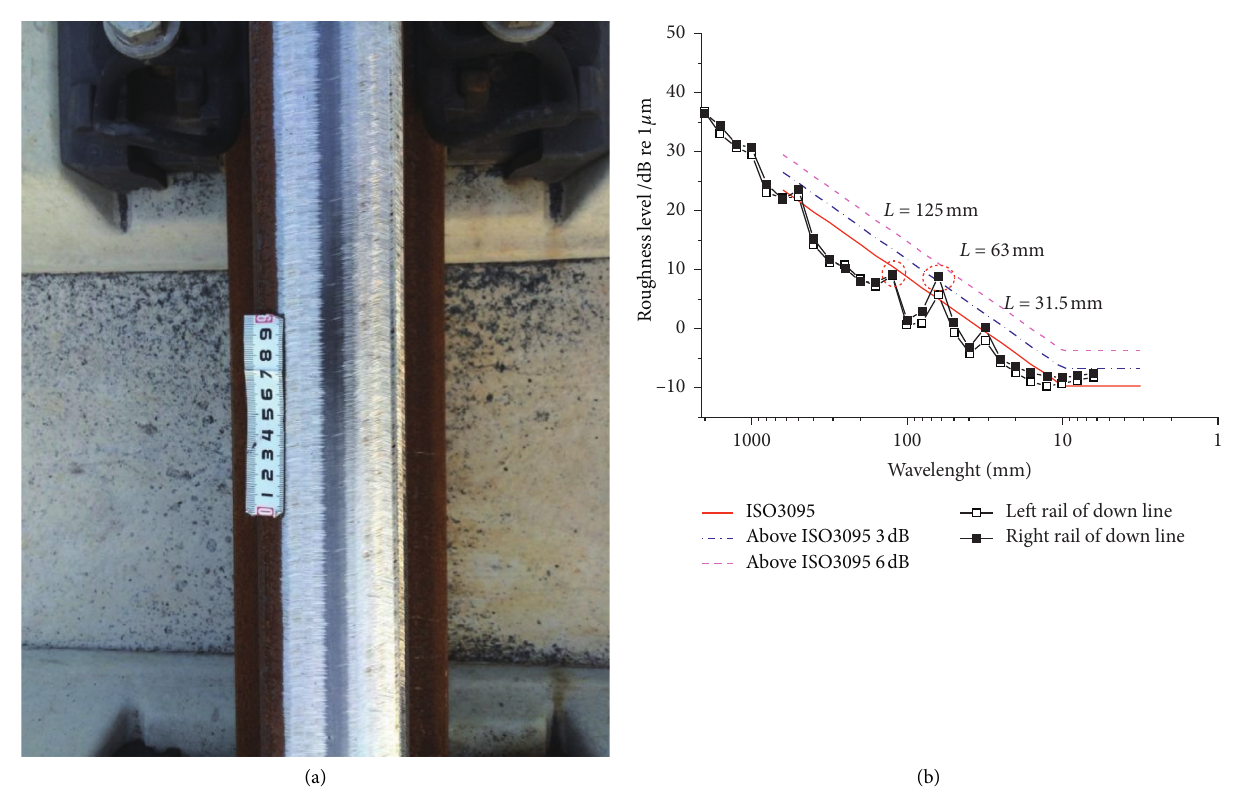
Figure 2: Picture and roughness spectra of rail corrugation in Section